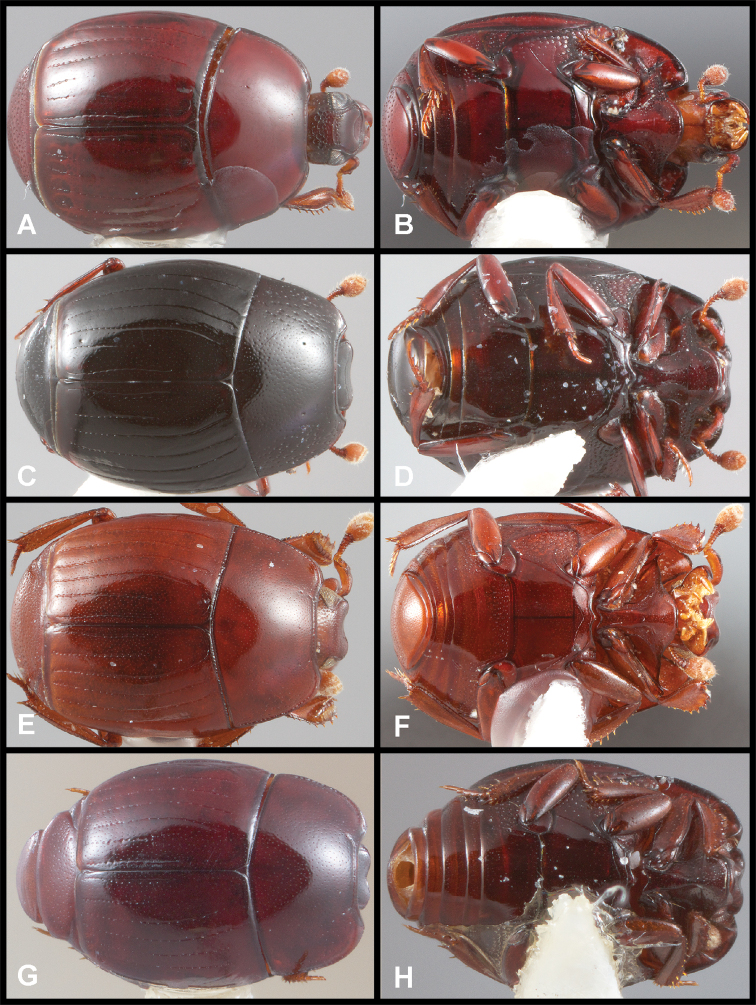
A, BPhelister
incertus: A dorsal habitus B ventral habitus C, DP.
okeefei: C dorsal habitus D ventral habitus E, FP.
blairoides: E dorsal habitus F ventral habitus G, HP.
pirana: G dorsal habitus H ventral habitus.